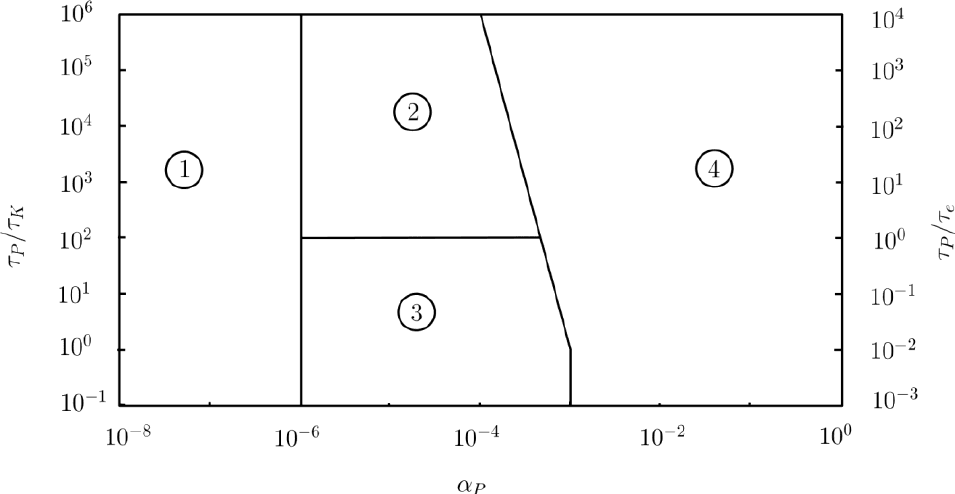
Figure 1. Classification map [4] showing the level of coupling required for numerical simulations and interaction between particles and turbulence for one-way coupling, two-way coupling where particles enhance the turbulent production, two-way coupling where particles enhance the turbulence dissipation, four-way coupling.